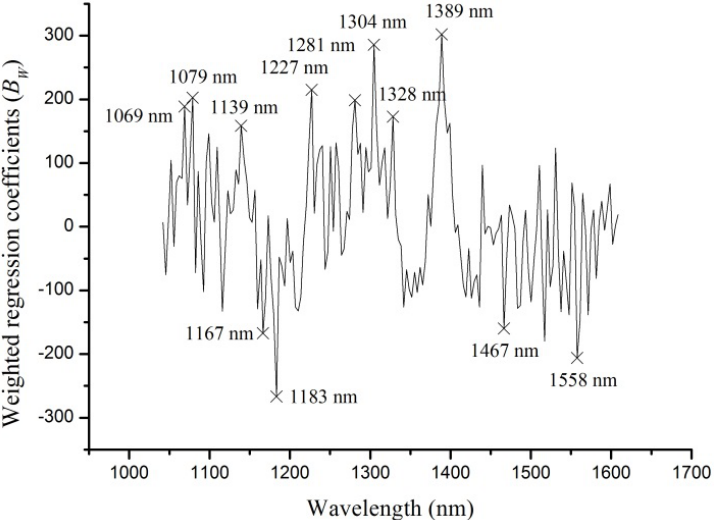
Figure 4. Weighted regression coefficients of PLS-DA model with selected